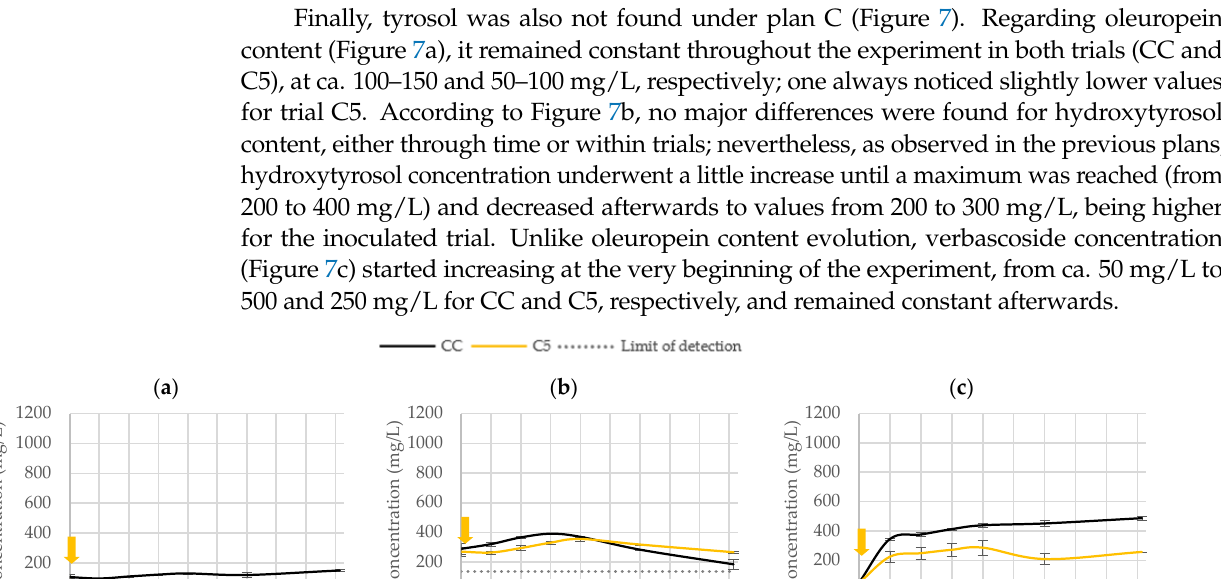
Figure 6. Evolution in phenolic profile, ( a ) oleuropein, ( b ) hydroxytyrosol, and ( c ) tyrosol, of table olive brine throughout fermentation under plan B. Arrows indicate the moment of inoculation with Lpb. pentosus i106 and the corresponding salt addition to all vessels.